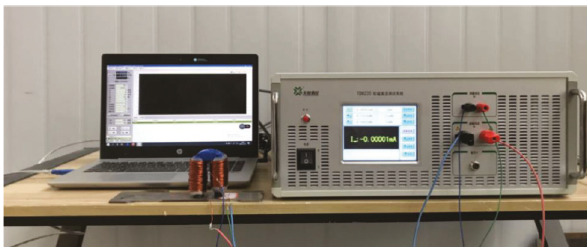
Figure 6: DC drive coercive force measurement system. Figure 7. The magnetic loop equation of the closed magnetic